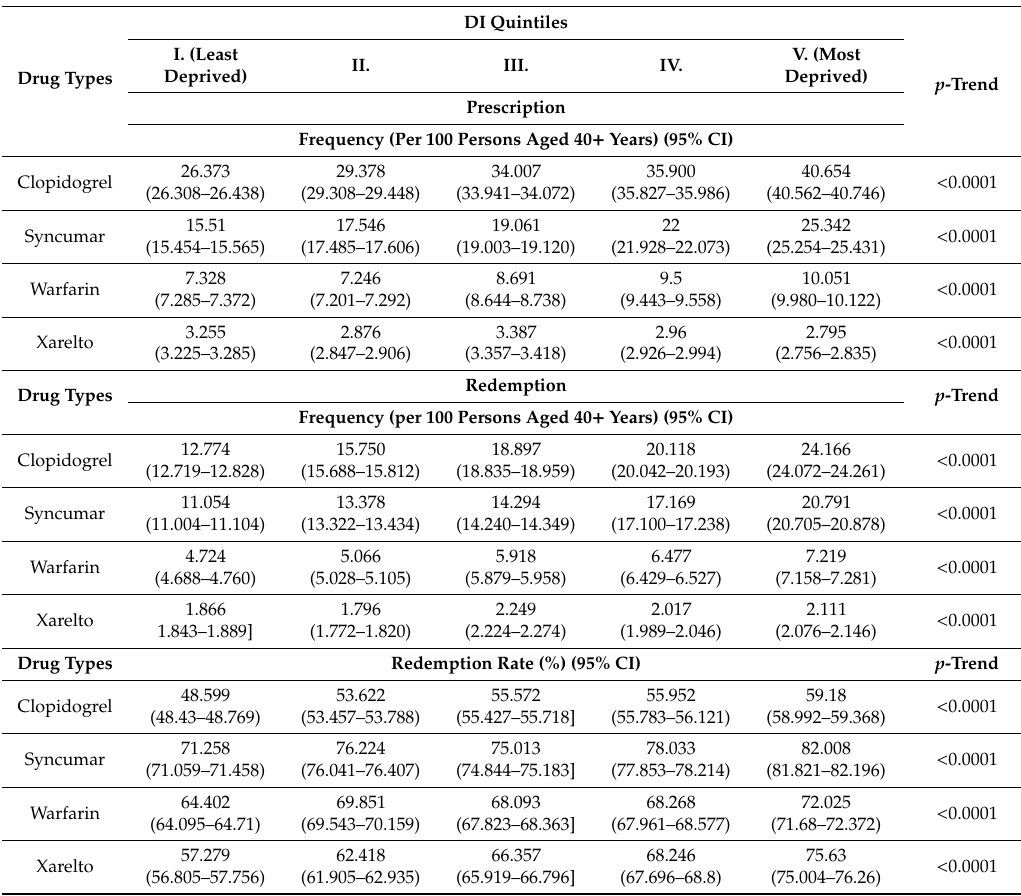
Table 3. Frequency of prescription and redemption of oral antithrombotic drugs per 100 persons aged 40 + years by DI quintiles at the district level, Hungary,